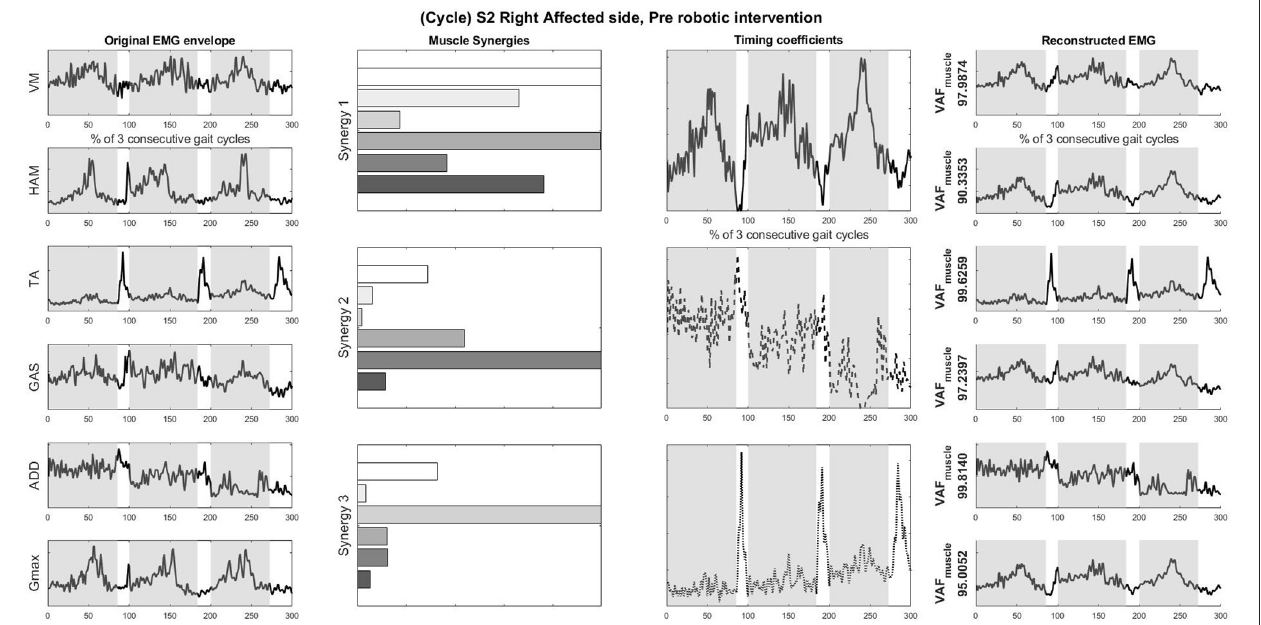
FIGURE 4 | Original EMG envelope, muscle synergies, timing coefficients and Reconstructed EMGs for affected side, pre HAL intervention, computed by NNMF with 3 synergies. Each bar of the synergy set is matched with the order of muscles in the “Original EMG” (Left) column, namely (from top bar to bottom bar) VM, HAM, TA, GAS, ADD, Gmax. Similarly, each plot in the “Individual Reconstructed EMG” column is matched with the order of the muscles in the “Original EMG” (Left) column. Each line pattern represents the reconstructed EMG from each motor module. Shaded areas denote stance phases.